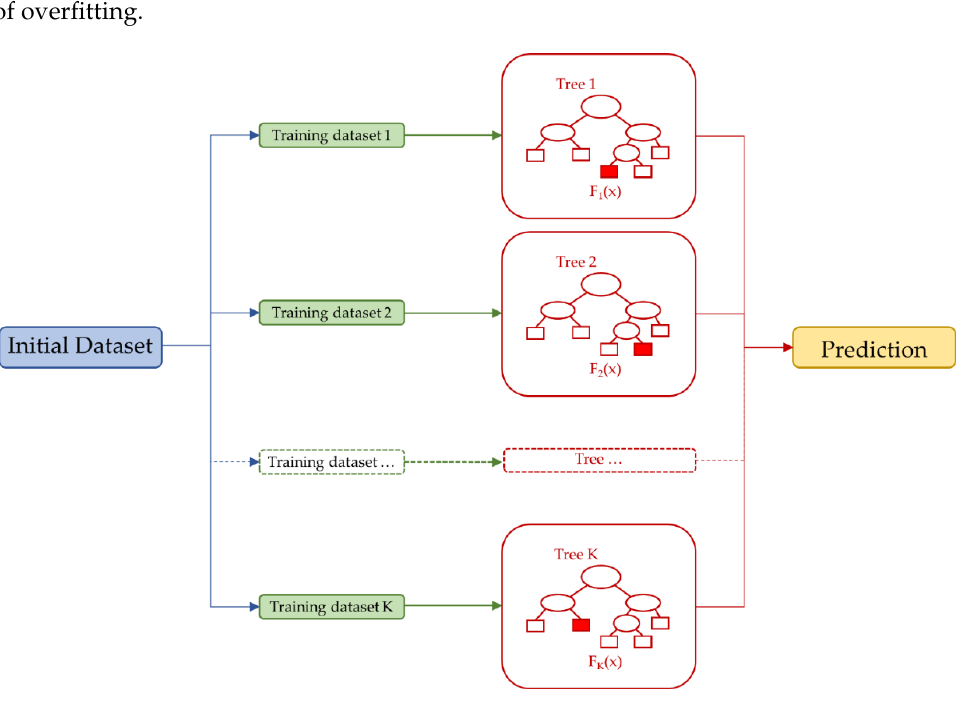
Figure 2. Typical architecture of the random forest algorithm.